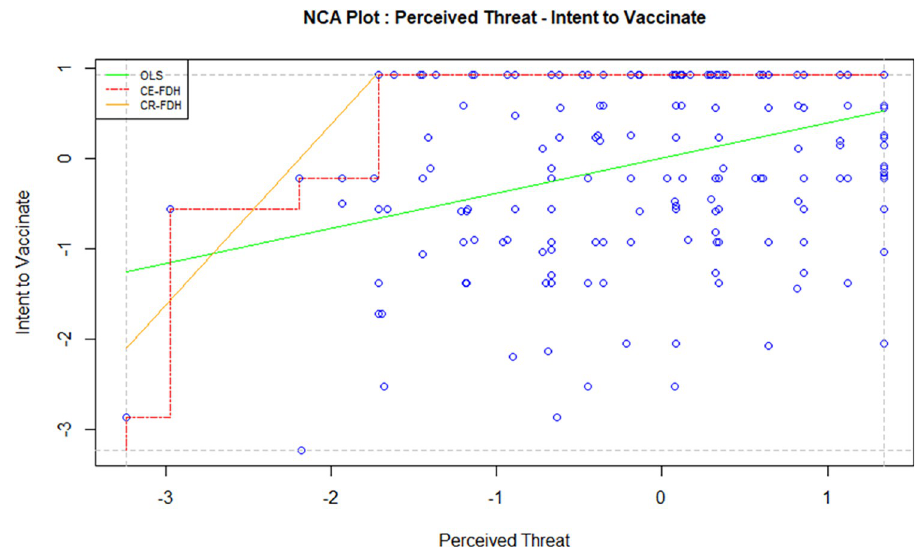
Fig 6. NCA (perceived